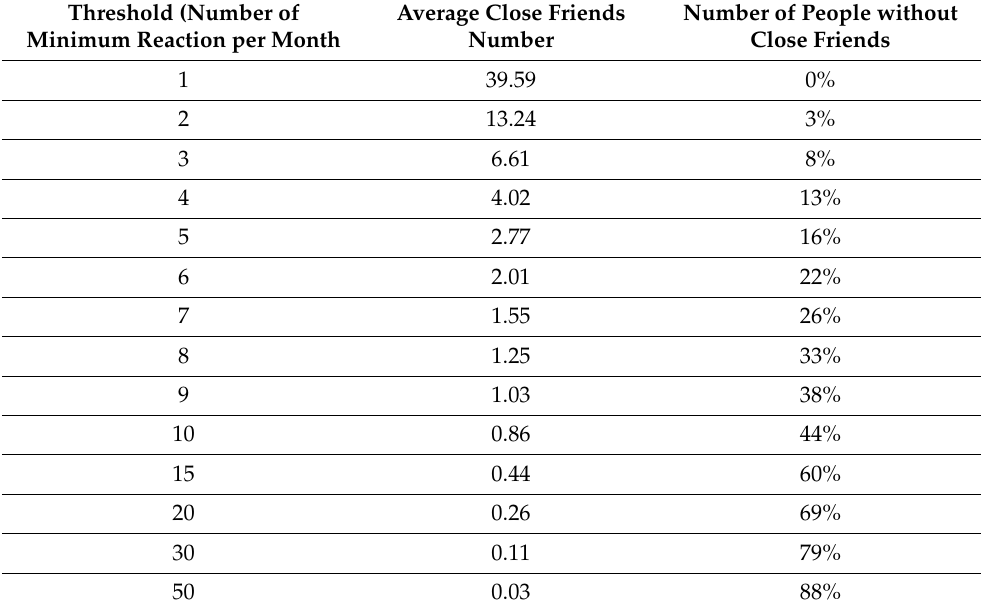
Table A1. Threshold related variation of the average number of close friends and number of people without close